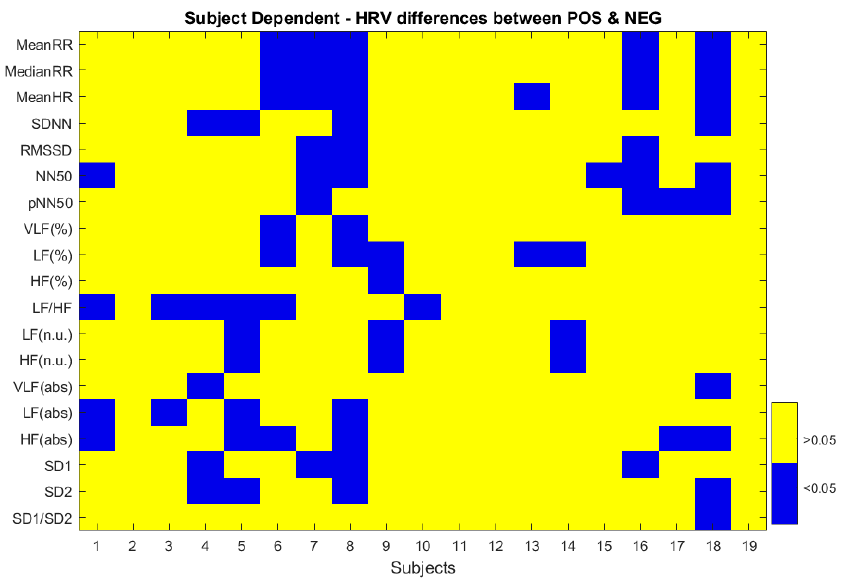
Figure 2. p -value results for the differences between positive and negative emotions at all the HRV measures and for all subjects.